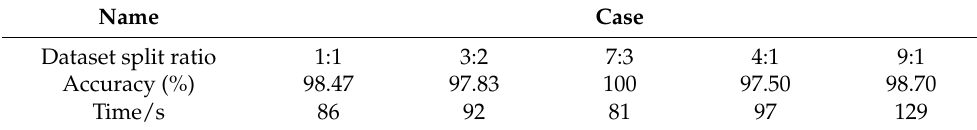
Table 5. Results of different splitting